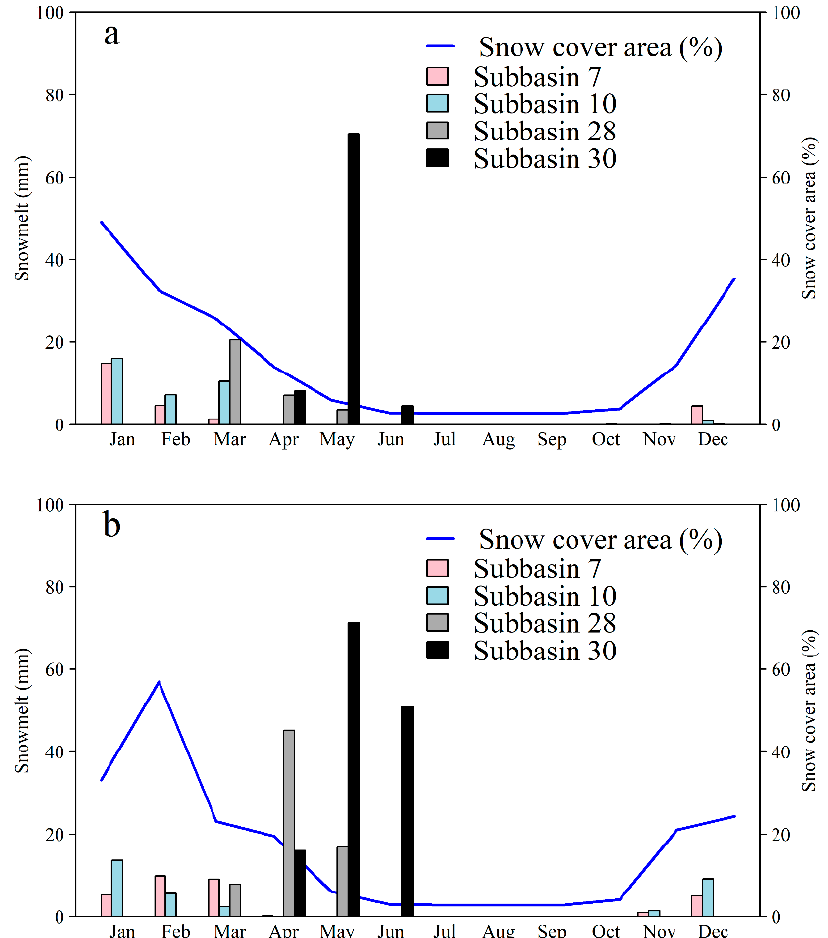
Figure 10. Comparison of the SWAT snowmelt and MODIS snow cover area over the BRB, ( a ) snowmelt and snow cover area (%) for 2013, and ( b ) snowmelt and snow cover area (%) for 2014. The snow cover area (%) data is adopted from the previous study in the BRB [31].